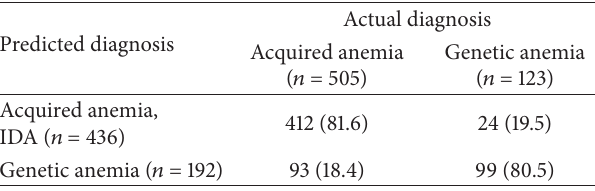
Table 4: Distribution of predicted versus actual disease classifica- tion in the validation set applying the classification type II. Number of patients (column